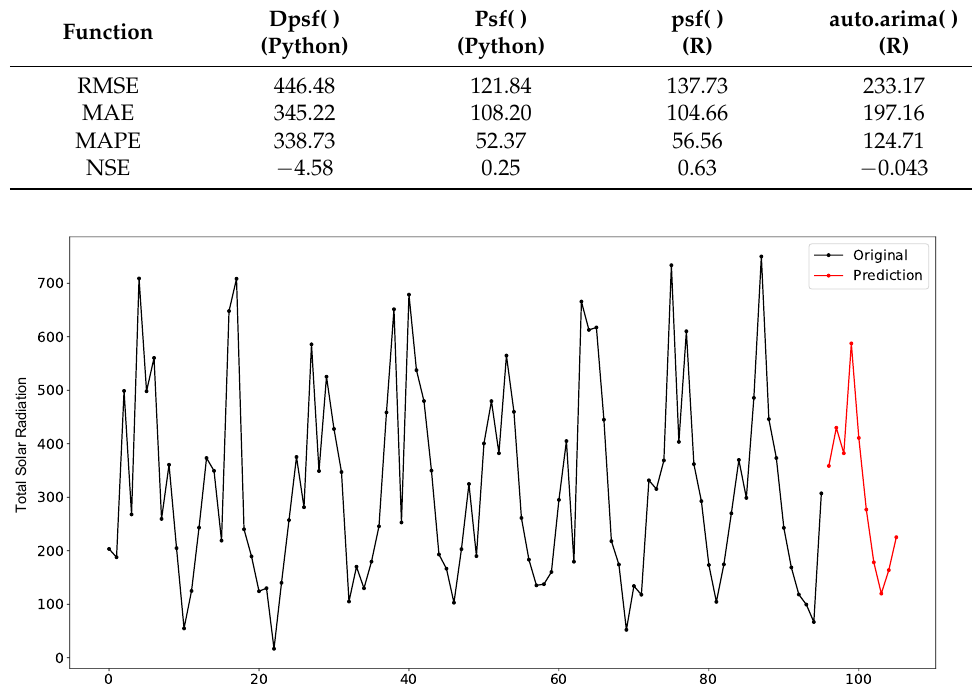
The error for Psf() was significantly less the that for auto.arima() and Dpsf() . The errors are listed in Table 8. Table 8. Comparison of forecast methods with different error metrics for “Total Solar Radiation” dataset.